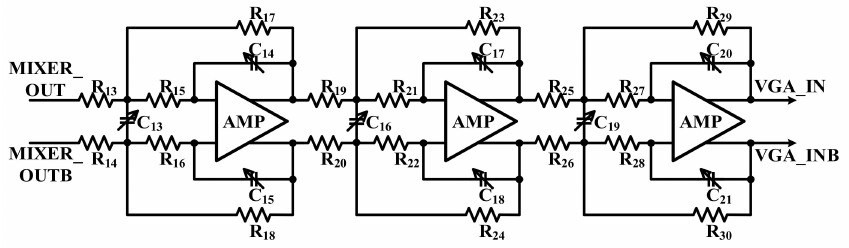
Figure 19. Block diagram of the low-pass